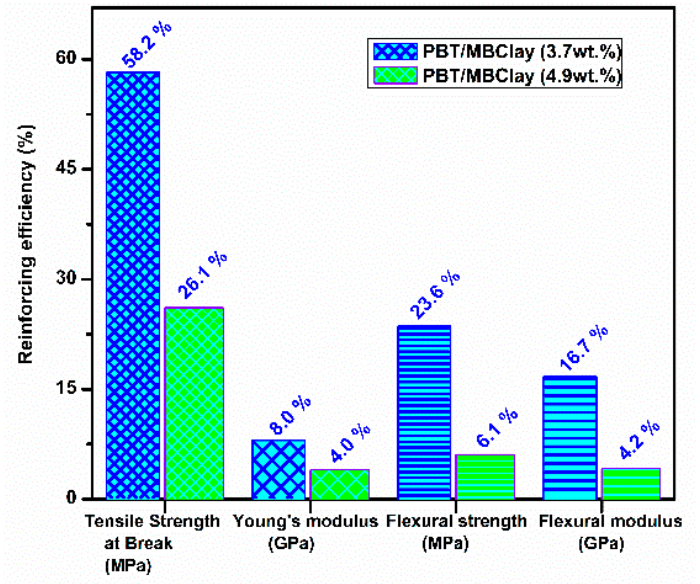
Figure 6. Reinforcing efficiency of MBClay on the mechanical properties of PBT/MBClay nano- composites.